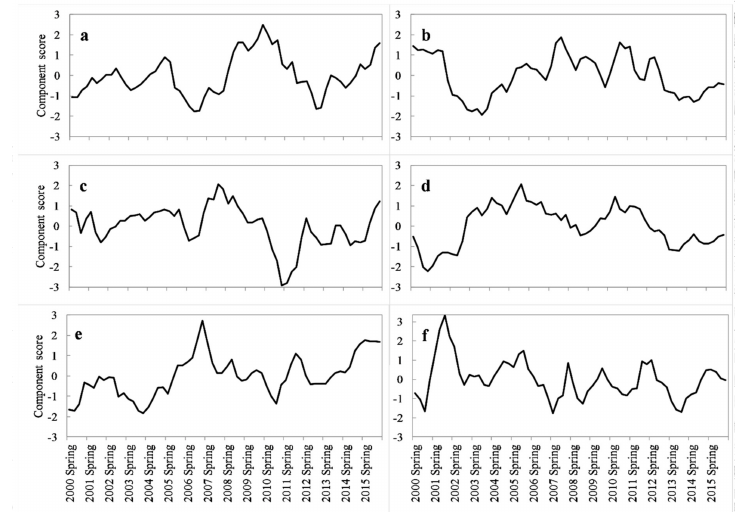
Figure 3. The temporal pattern of the first six PCs estimated from the original monthly self-calibrating Palmer Drought Severity Index (scPDSI) from 2000 to 2015 ( a – f ). High component score indicates more wet conditions in that year while negative values indicate dry conditions occurred. See the correlated spatial pattern of each PCs in supplement materials.